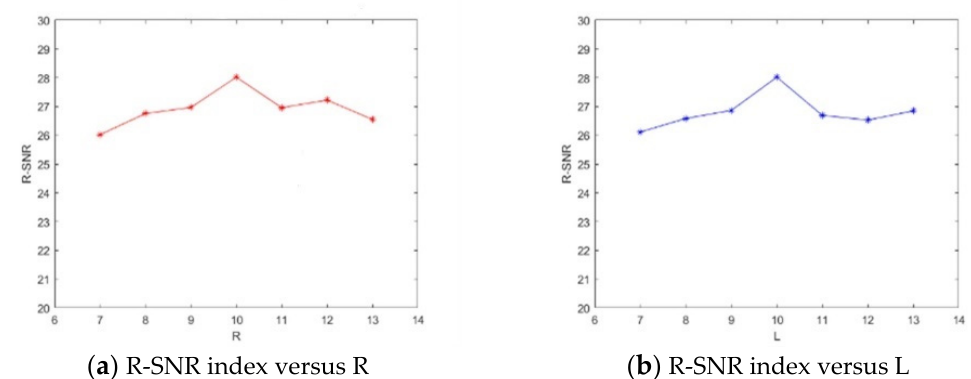
Figure 9. R-SNR varies with different R and L on the Pavia University dataset.